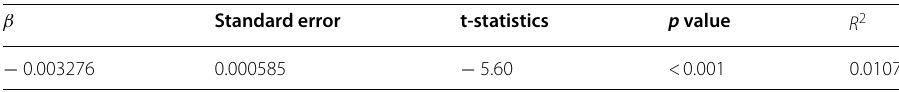
Table 3 Results of the fixed effects panel regression model